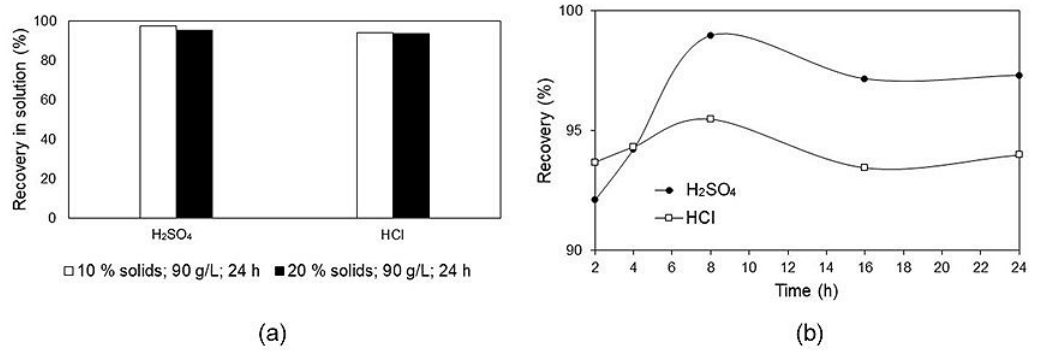
Figure 6. ( a ) Influence of the percentage of solids in the recovery of indium with H 2 SO 4 and HCl; ( b ) Influence of the leaching time in the recovery of indium with H 2 SO 4 and HCl (20% of